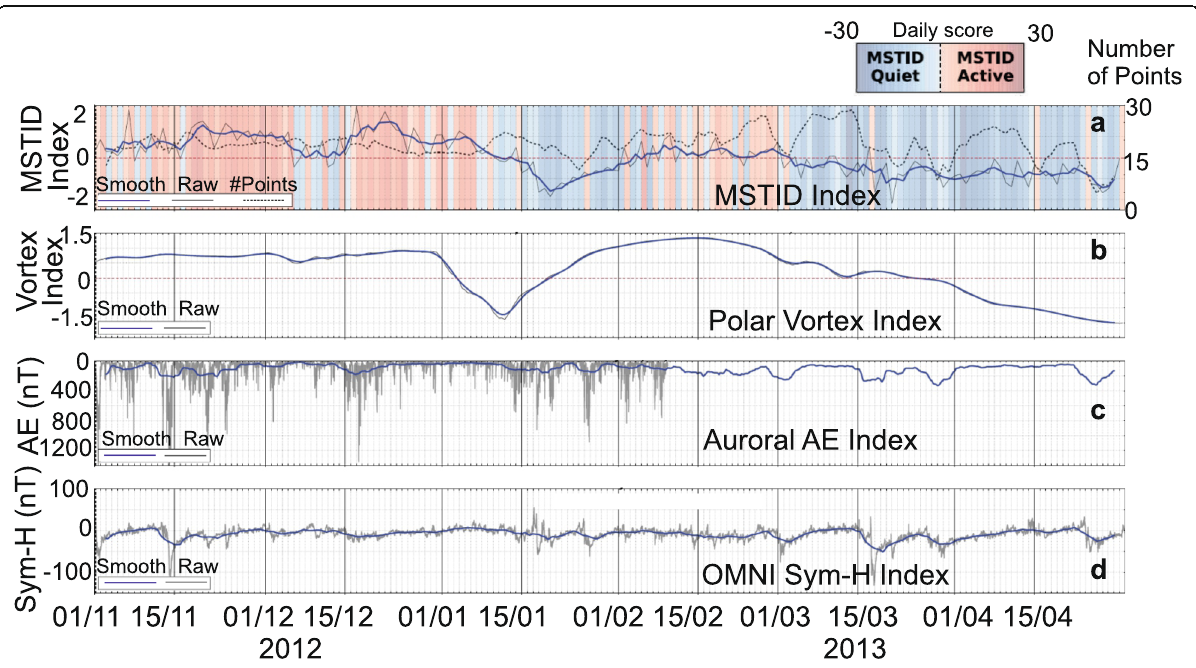
Fig. 30 Time series of North American SuperDARN MSTID, polar vortex, and geomagnetic activity indices for the 2012 – 2013 observational season. a Continental MSTID index (gray and blue traces) and daily number of good sampling windows (dotted line). Background color indicates daily MSTID score and classification, with MSTID-active days in reds and MSTID-quiet days in blues. b Polar Vortex Index. c Negative AE index. d SYM - H index. In all panels, gray traces show raw data while blue traces show a 4-day running mean smoothing. Adapted from Fig. 9 of Frissell et al.